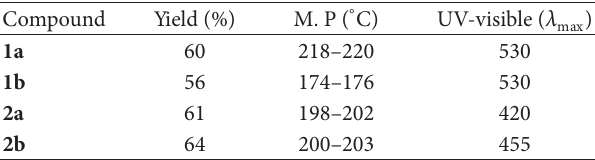
T 1: Physical characterization of the synthesized compounds.